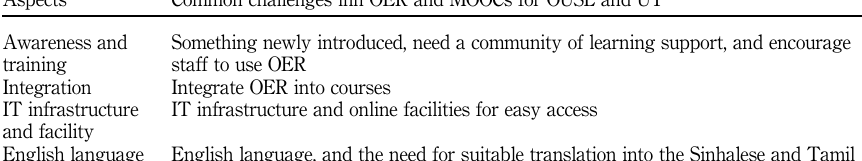
Table 17. Challenges in OER and MOOCs